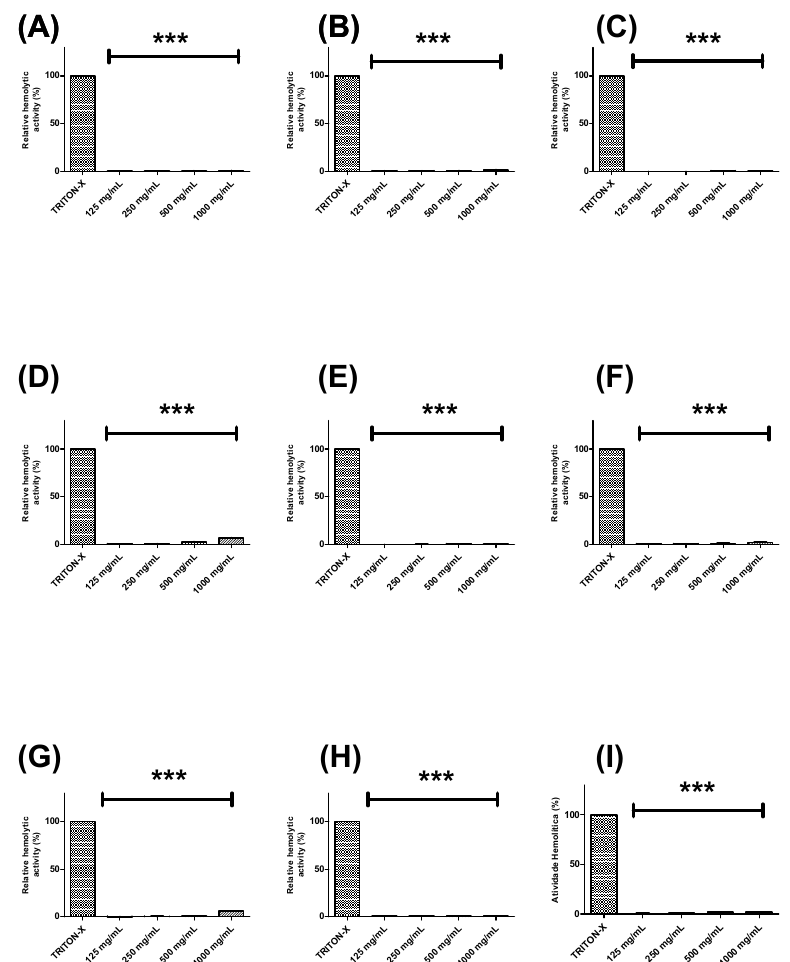
Figure 3. Hemolytic activity of the fractions obtained from the methanolic extract of Buchenavia tetraphylla leaves. ( A ) BTFA (Fraction A); ( B ) BTFB (Fraction B); ( C ) BTFC (Fraction C); ( D ) BTFD (Fraction D); ( E ) BTFE (Fraction E); ( F ) BTFF (Fraction F); ( G ) BTFG (Fraction G); ( H ) BTFH (Fraction H); ( I ) BTFI (Fraction I). *** Significant di ff erences in relation to triton-X ( p < 0.0001). The results are expressed as the mean ± standard deviation calculated from three independent assays performed in quadruplicate ( n = 4 ).